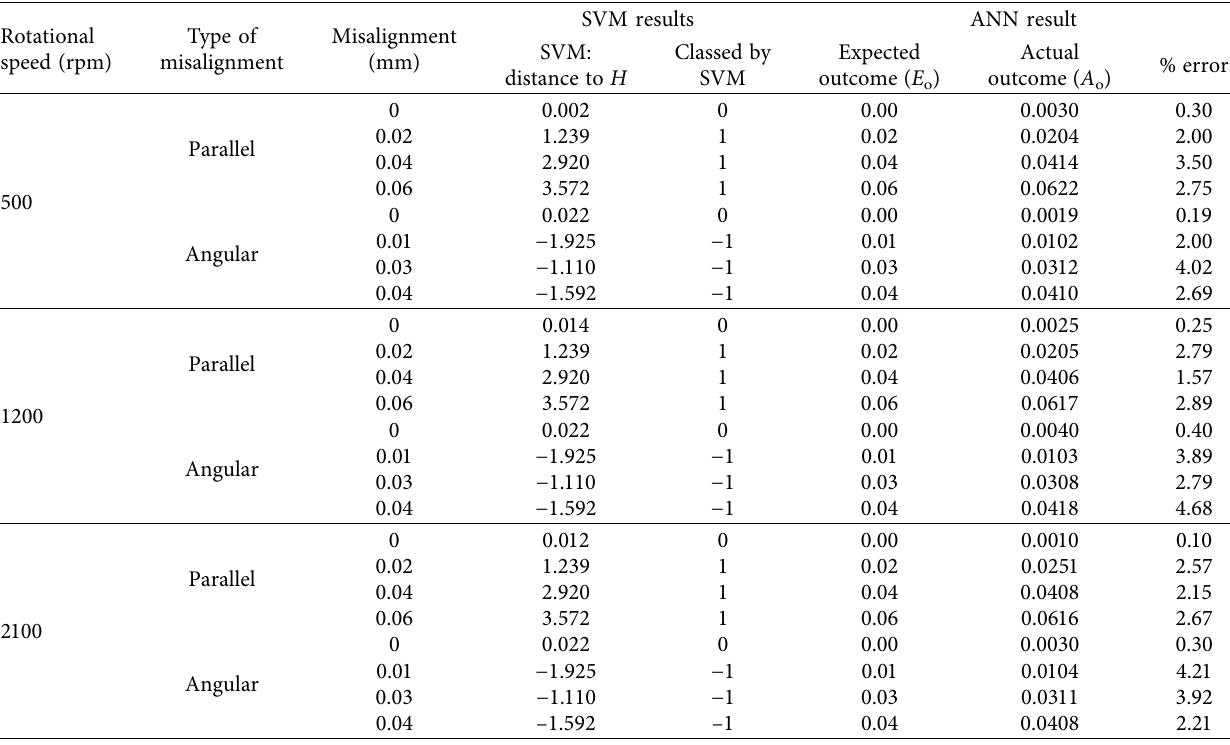
Table 6: Results obtained using classification and prediction of the shaft misalignment method. Rotational